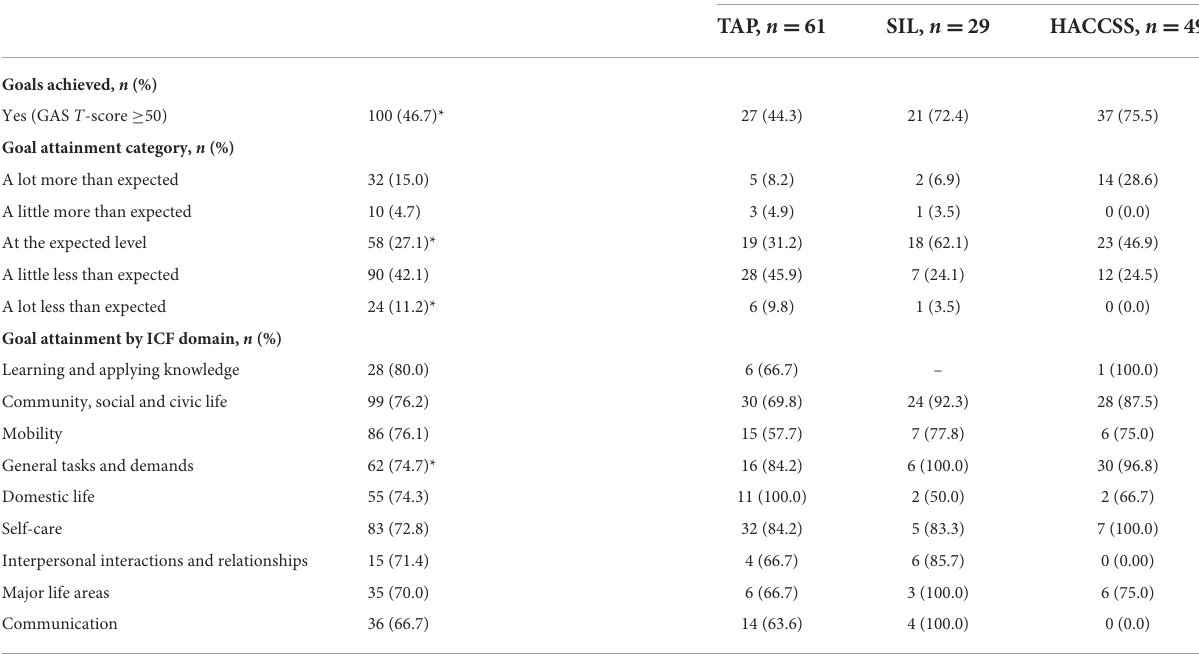
TABLE 3 Goal attainment at discharge from post-acute services, 2011–2020 ( n = 353). Outcome